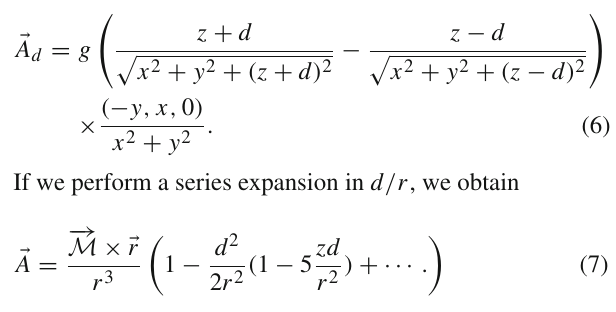
The magnetic field of a monopole located at the origin of the coordinate system is given by